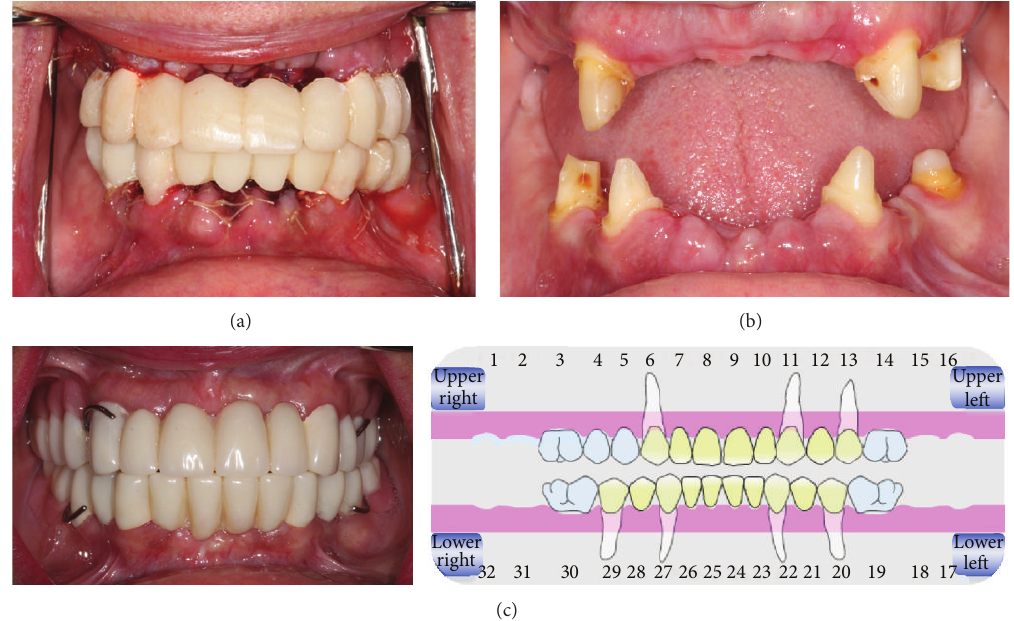
Figure 5: Steps of phase I treatment. (a) First set of provisional prostheses delivered after planned teeth extraction. (b) Intraoral picture 1 month after planned teeth extraction. (c) Intraoral picture depicting delivery of enhanced provisional